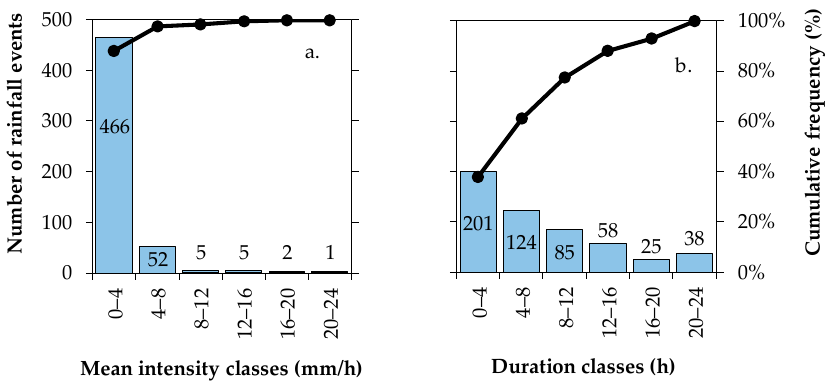
Figure 6. Distribution frequencies of the total 531 rainfall events in bin classes of ( a ) mean intensity and ( b ) duration. The lines are the cumulative frequencies of the classes.